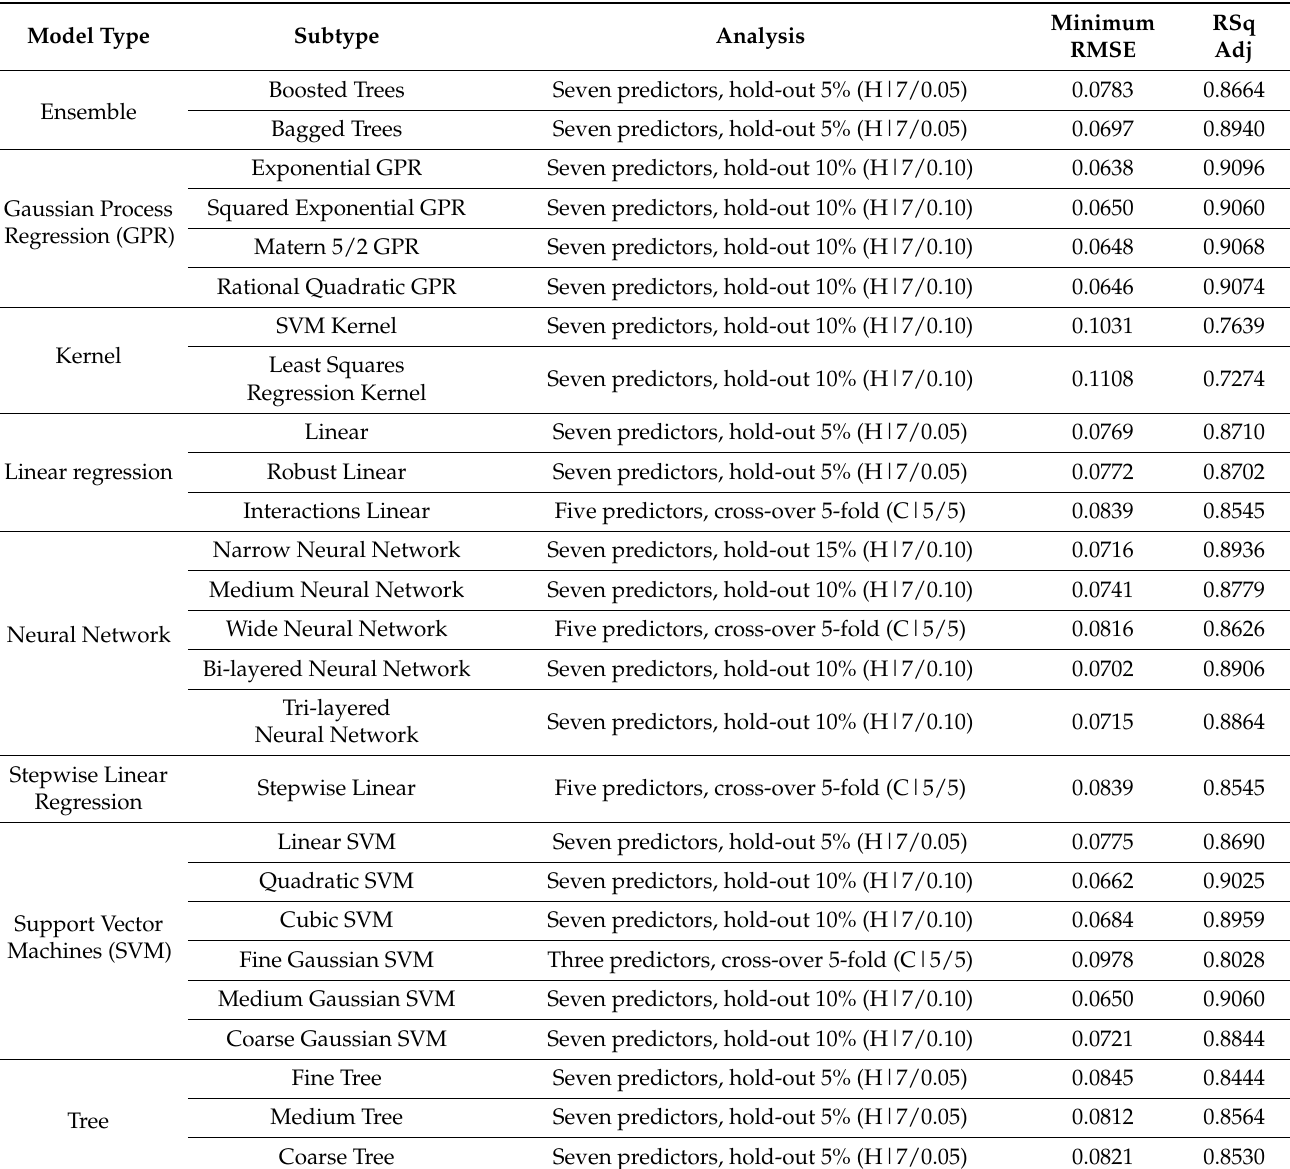
Table 9. Fitted regression models with multiple variables and validation RMSE